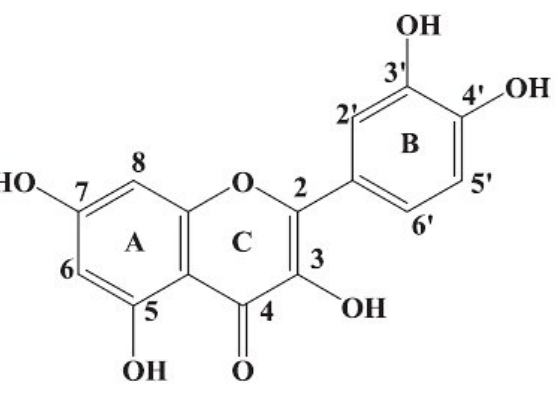
Figure 1. Structure of quercetin.